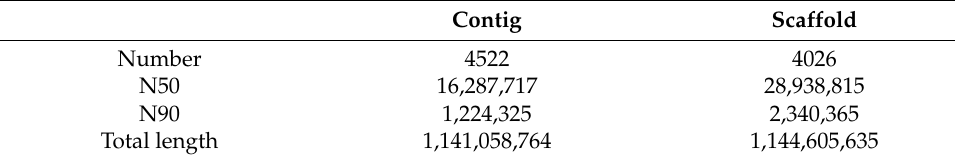
Table 1. Assembly statistics of the yellow-throated bunting